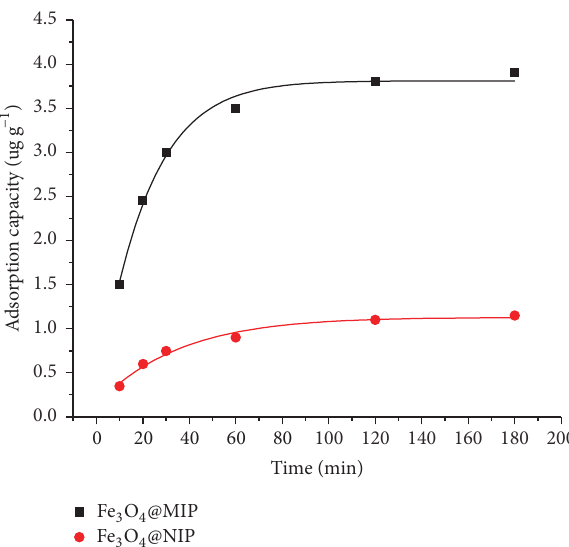
Figure 7: Adsorption kinetics of Fe 3 O 4 @MIPs and Fe 3 O 4 @NIPs. Figure 8: Adsorption isotherms of Fe 3 O 4 @MIP and Fe 3 O 4 @NIP to TBT.